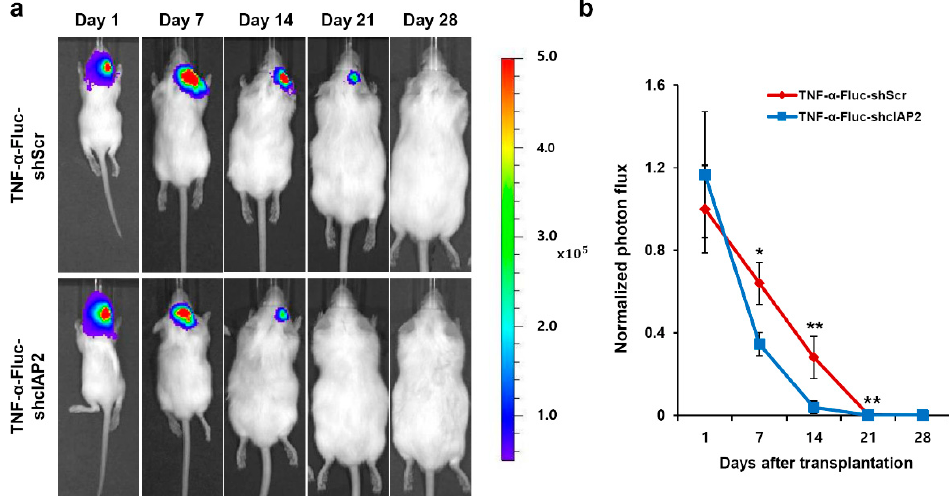
Figure 2. TNF- α pretreatment improved hNPC survival through cIAP2 upregulation. Inhibition of cIAP2 abolishes TNF- α -induced survival of hNPCs in HI brain injury. ( a ) Representative images of HI-injured mice transplanted with TNF- α -Fluc-shScr or TNF- α -Fluc-shcIAP2 are shown. The color scale bar is in photon / s / cm 2 / sr. ( b ) Bioluminescent signals normalized to signals at 1 day after TNF- α -Fluc-shScr cells injection (n = 7 per group). * p < 0.05 and ** p < 0.01. Data are presented as the mean ±